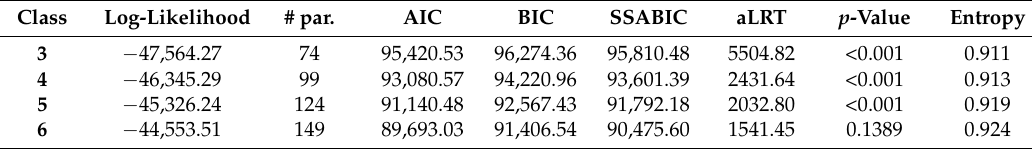
Table 1. Goodness-of-Fit Indices Comparing Class Models of